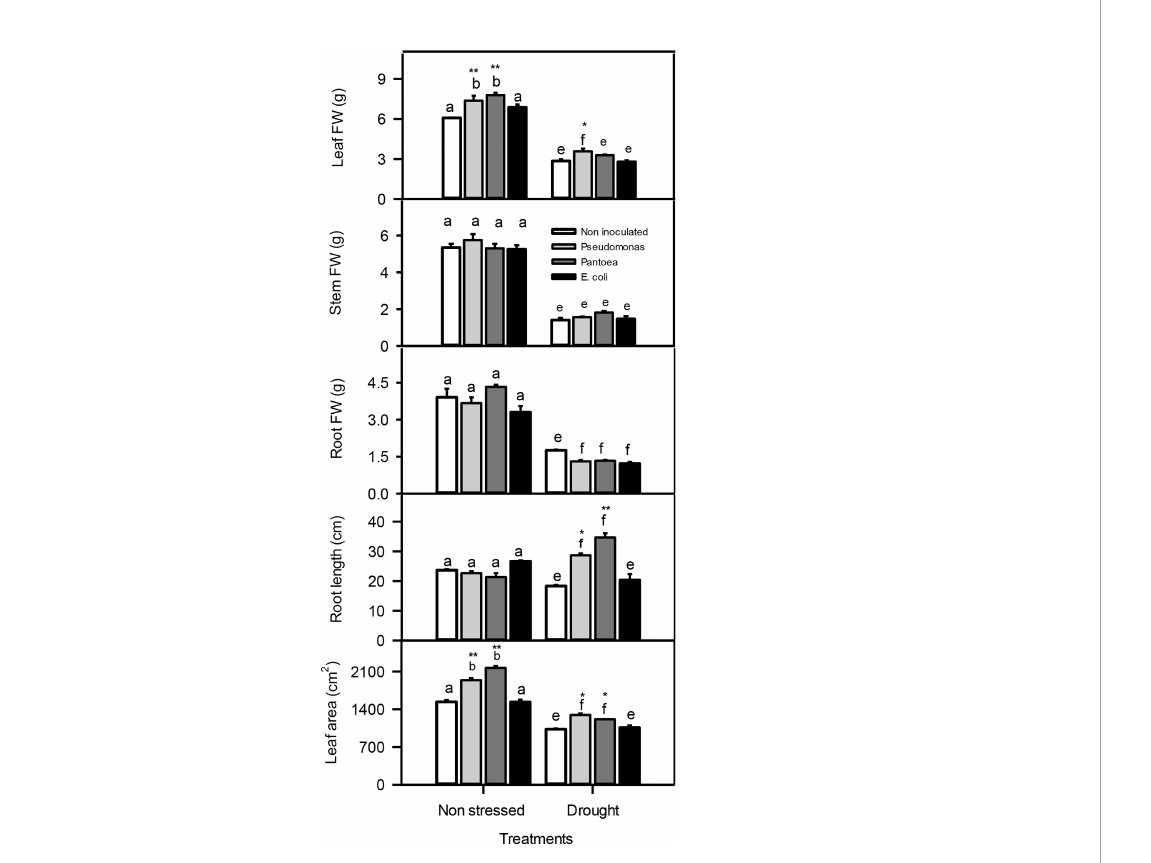
FIGURE 3 Leaf, stem, and root fresh weight (FW), root length, and leaf area of drought-stressed and non-stressed (well-watered) Hordeum vulgare inoculated with three bacterial strains ( Pseudomonas sp. (ITS Group 11), Pantoea sp. (ITS Group 2), or E. coli ). F and P (** P < 0.01, *P < 0.05) values of the two-way ANOVAs are presented, drought, bacteria and drought x bacteria interaction. The lower case letters shows the signi fi cant differences among means (P< 0.05) assessed by Fisher ’ s protected least signi fi cance difference